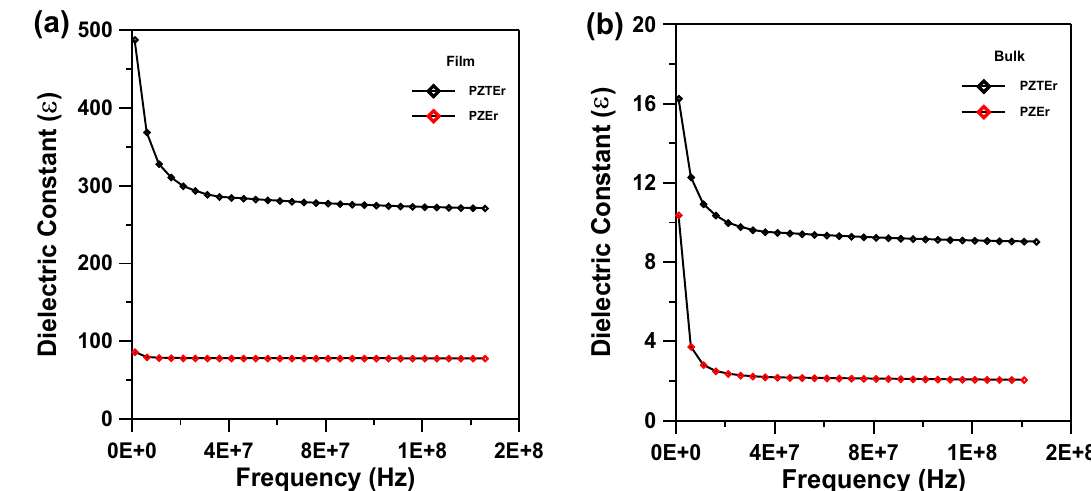
Figure 6. ( a ) Dielectric constant versus frequency for Er-doped PEZ and PEZT thin film samples. ( b ) Dielectric constant versus frequency for Er-doped PEZ and PEZT bulk samples.